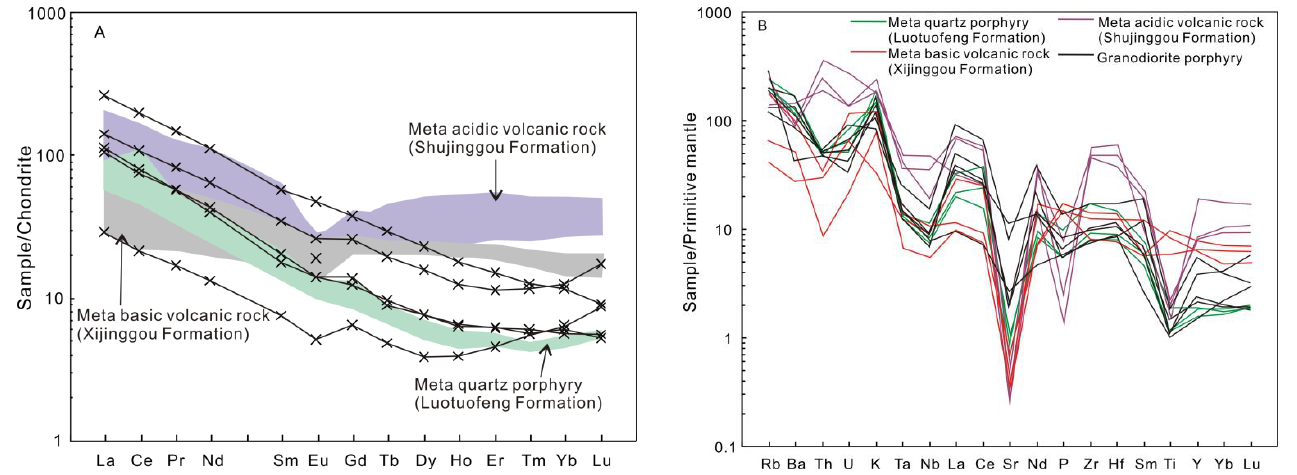
Figure 10. Chondrite-normalized REE patterns diagram ( A ) and primitive mantle normalized trace element spider diagram ( B ) for Tongkuangyu granodiorite porphyry (normalization data after Sun and McDonough, 1989 [53]; regional rock data source as same as Figure 9).